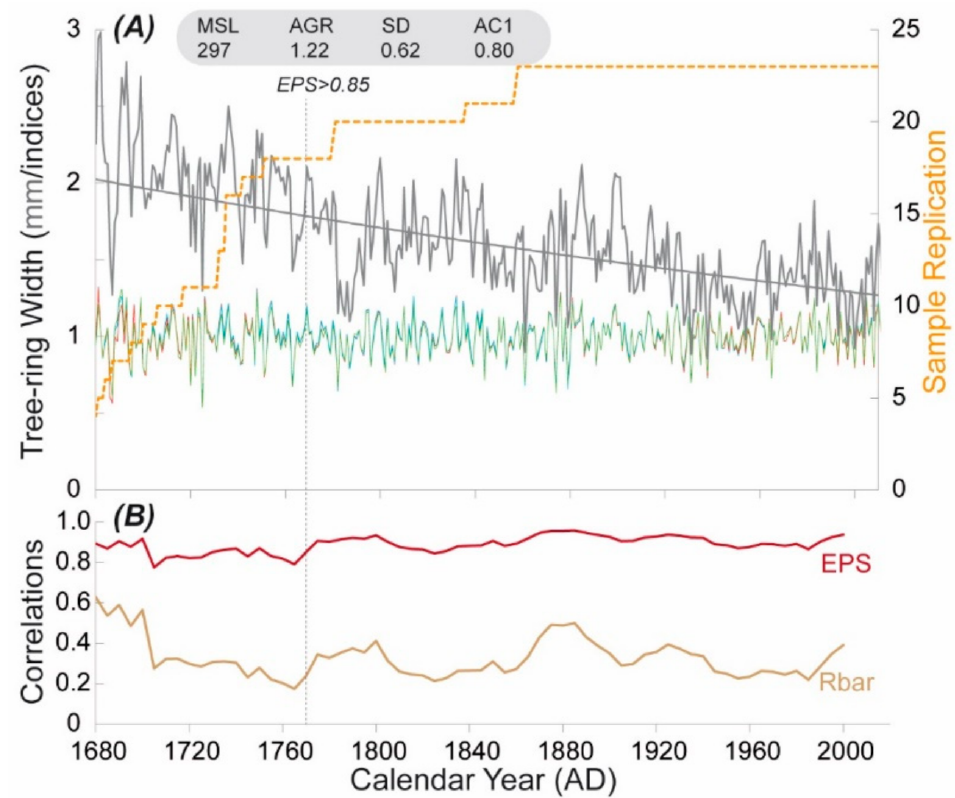
Figure 2. ( A ) Raw tree-ring width chronology with a trend approximated by an exponential function, sample replication, and three slightly different pine residual chronologies after applying three different standardization techniques: cubic smoothing splines with 50% frequency cut-off at 150 years, negative exponential functions, and regional curve standardization (RCS) method. The upper left inset provides insight into data characteristics. Basic statistical parameters (MSL—mean segment length; AGR–average growth rate; SD–standard deviation; AC1–first-order autocorrelation) are shown. ( B ) Expressed population signal (EPS) and inter-series correlation (Rbar) of the indexed TRW series. EPS and Rbar statistics were calculated over 30-year windows lagged by 25